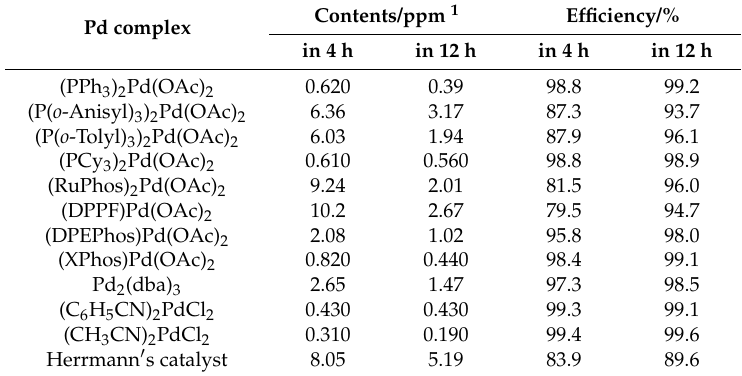
Table 2. Results of competitive sequestration of palladium complexes from acetonitrile solutions.